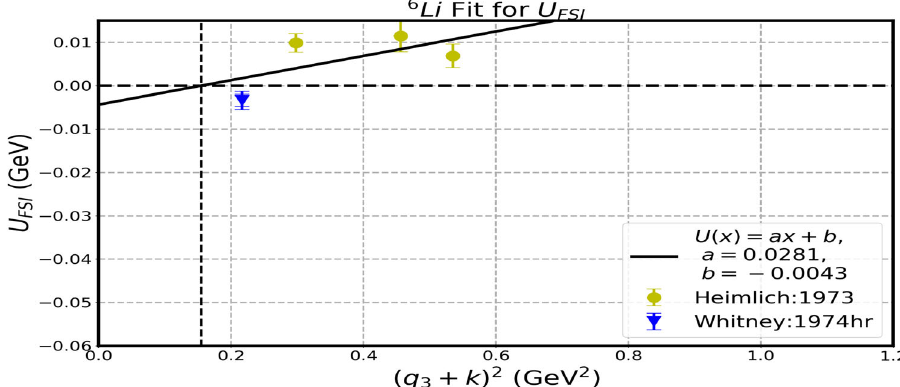
= 0 . 275 GeV) QE differential cross sections Au ( k P F 79